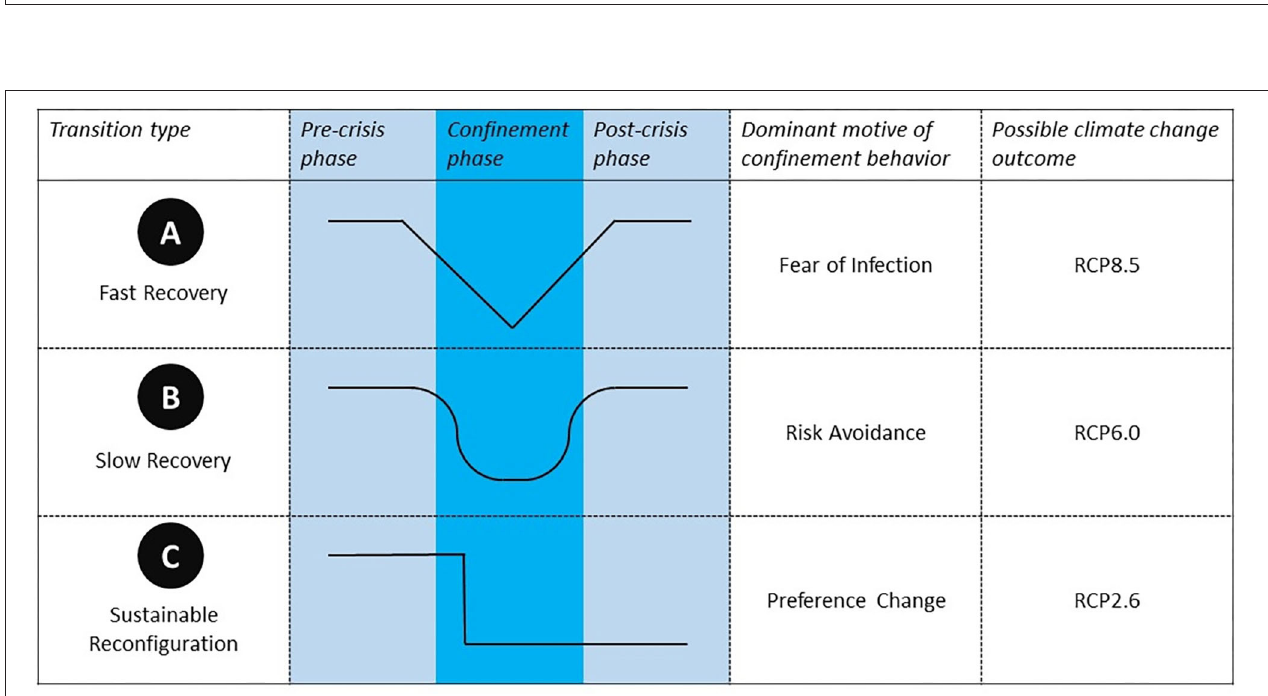
FIGURE 7 | Stylized transition types of pre- and post-Corona consumption levels and climate change outcomes, depending on the dominant motive of confinement behavior. Source: Own graph.